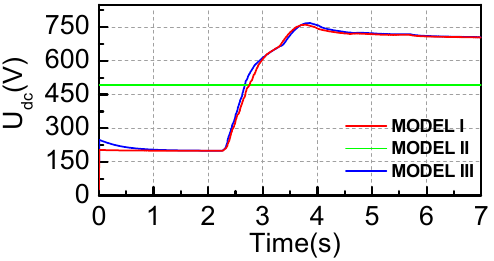
Figure 14. The current trajectory when the torque setpoint is 190 Nm.